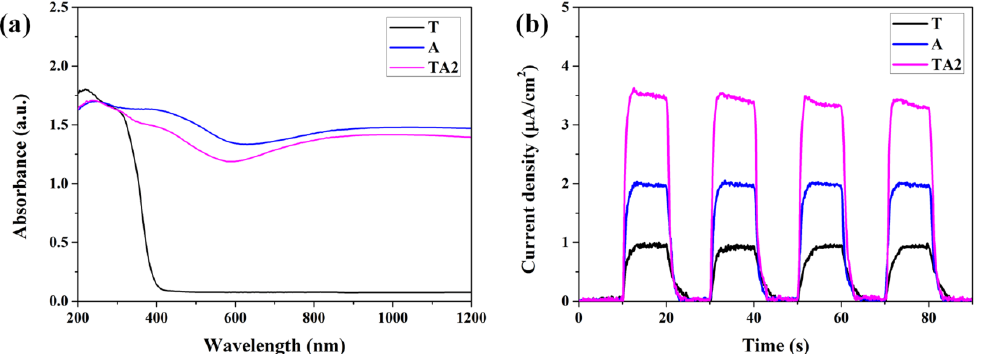
Figure 9. ( a ) UV-Vis absorbance spectra and ( b ) photocurrent responses of the T, A, and TA2 samples.